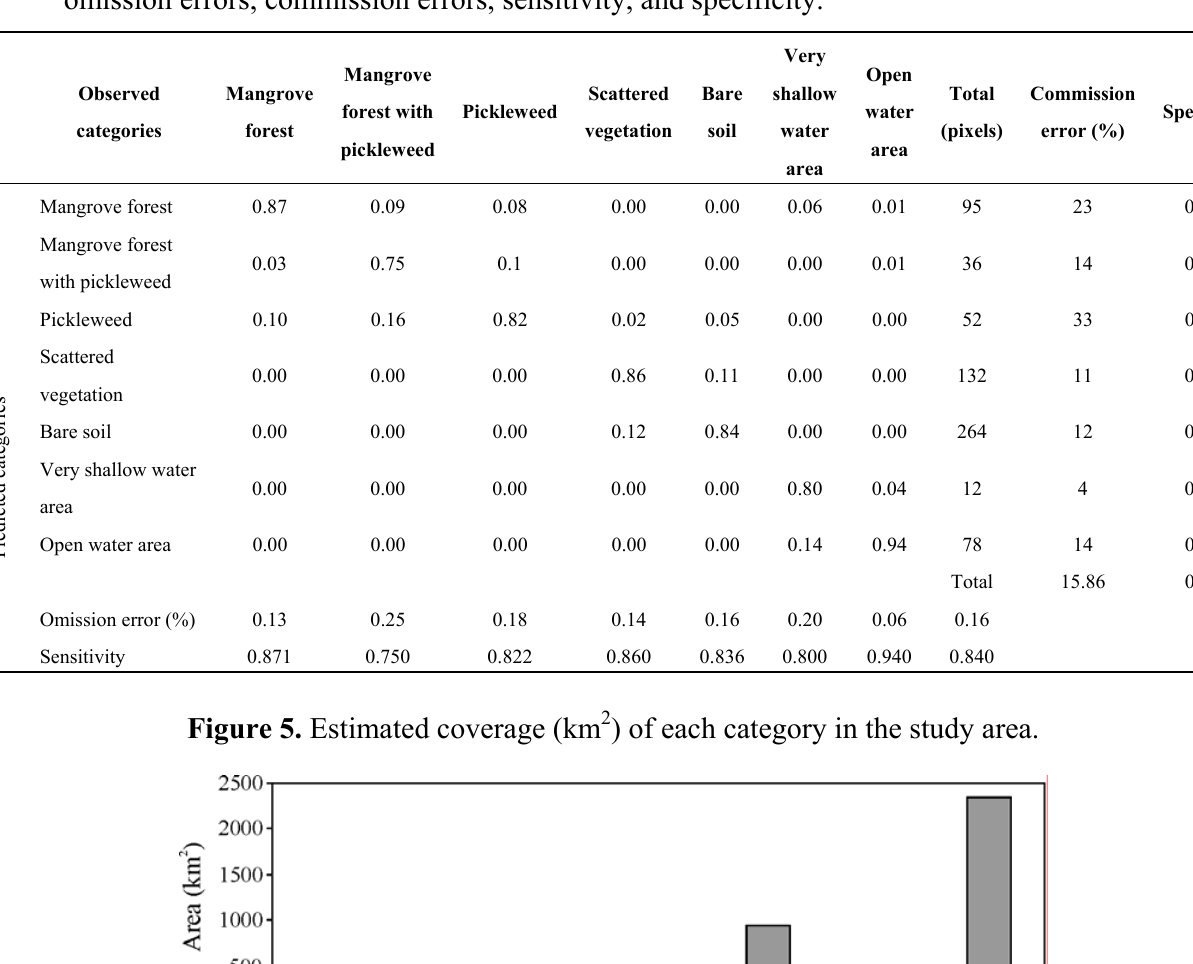
Table 4. Confusion matrix between categories (proportion and total number of pixels), omission errors, commission errors, sensitivity, and specificity.